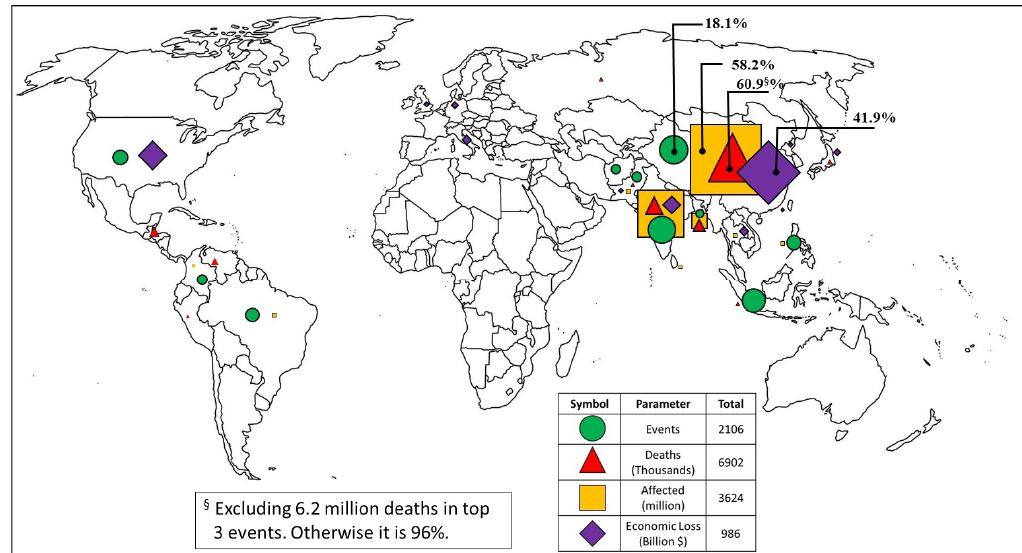
Figure 5. Global hotspots for hydrological disasters based on data for the top 10 countries in each category from 1900 to